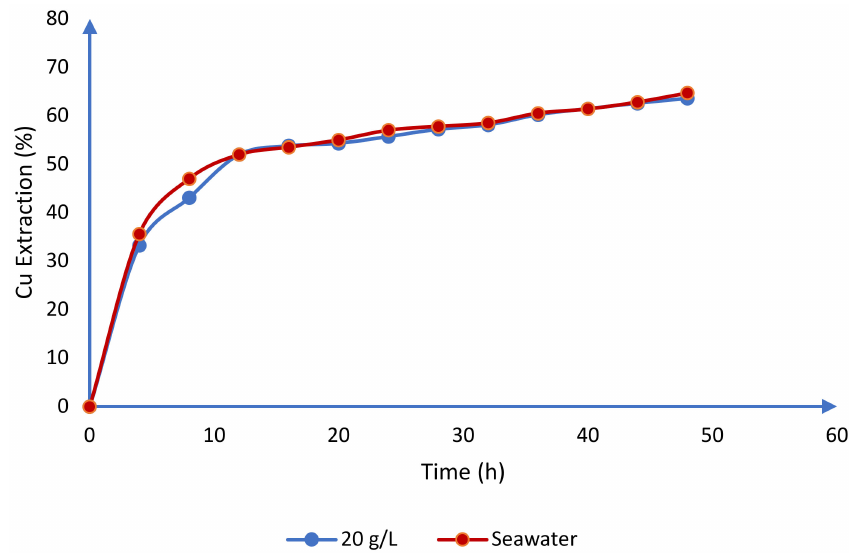
Figure 7. Comparison between the use of seawater and synthetic chloride (20 g/L) for the dissolution of chalcocite in an acid medium (T = 25 ◦ C, H 2 SO 4 = 0.5 mol/L) (Modified from: